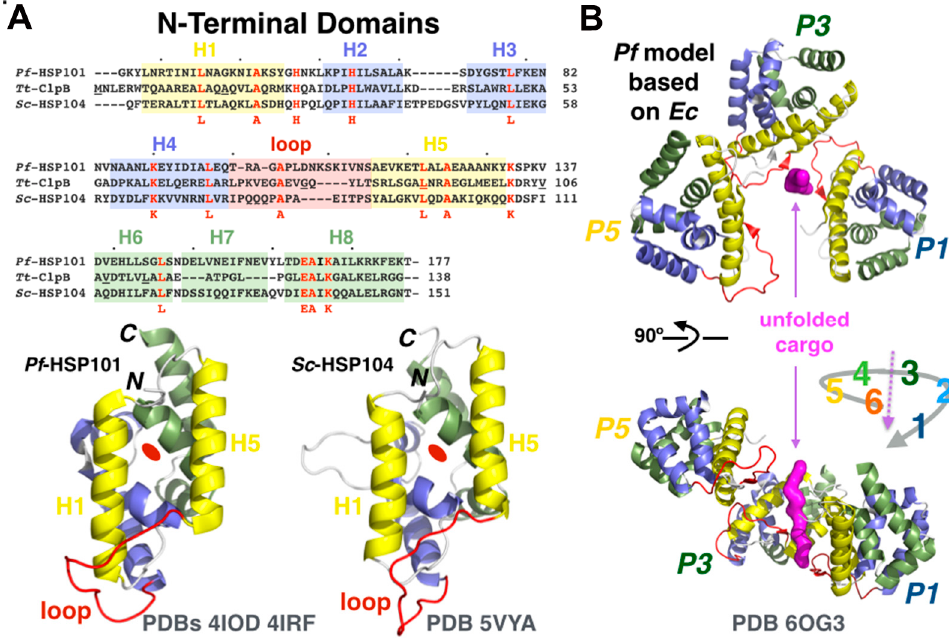
Figure 7. Promiscuous substrate binding by the N -terminal domain of HSP101. ( A ) Structure-based sequence alignment of the NTDs from Pf -HSP101, Tt -ClpB, and Sc -HSP104. Residues from Tt -ClpB NTD shown to interact with denatured proteins based on CSP NMR analysis [75] were located in helices H4 and H5 and the connecting loop. ( B ) Possible binding mode for denatured substrates by a trimer of N -terminal domains of Pf -HSP101 in the PTEX based on the structure of Ec -ClpB bound to casein [76] . As in Ec -ClpB NTDs, Pf -HSP101 NTDs could engage denatured extended polypeptides using a hydrophobic groove delineated by helices H1 and H5 (yellow) and the loop (red) between helices H4 and H5 [60] .